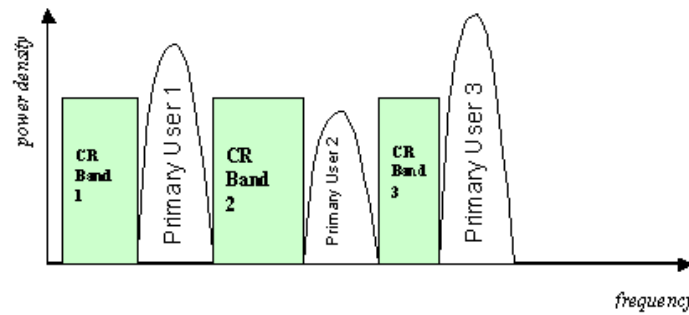
Figure 46. Overlay CR